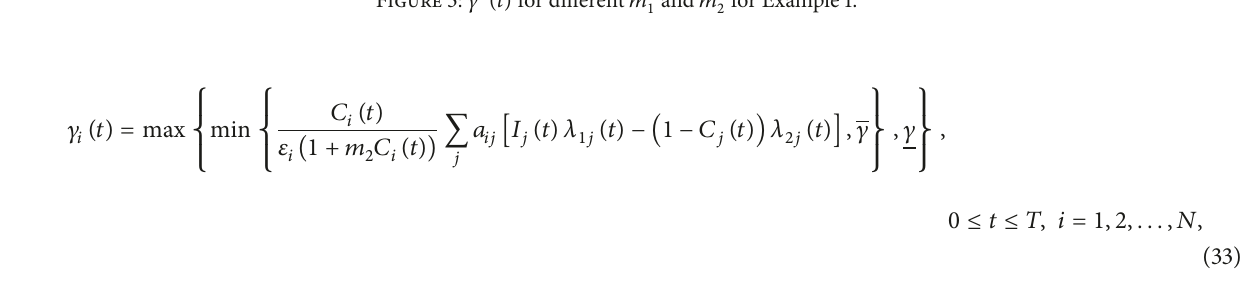
Figure 3: 𝛾 ∗ (𝑡) for different 𝑚 1 and 𝑚 2 for Example